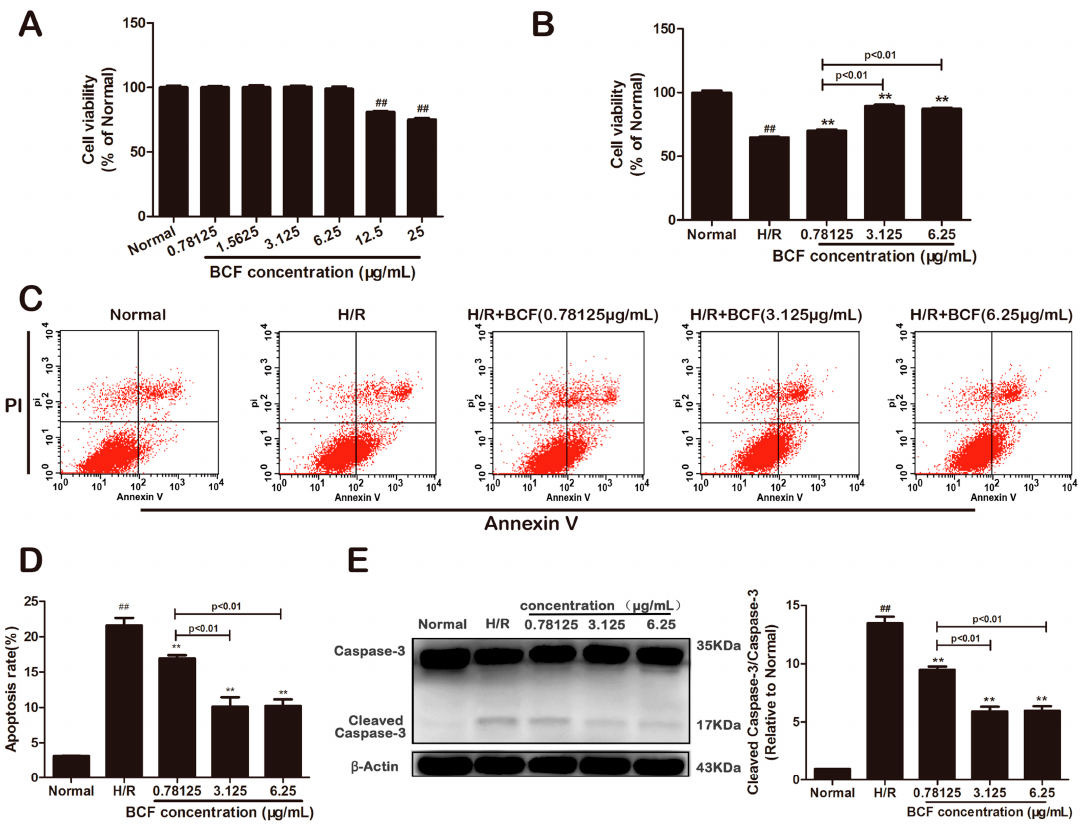
Figure 1. Effects of BCF on H/R induced myocardial apoptosis. H9c2 cells were pretreated with the indicated BCF concentrations for 4 h followed by 6 h of hypoxia and 12 h of reoxygenation or pretreated with indicated BCF concentrations for 24 h before the detection of relevant indexes. ( A ) Cytotoxicity was detected by CCK-8 assay; ( B ) Cell viability was determined by CCK-8 assay; ( C ) The apoptotic ratio of H9c2 cardiomyocytes was measured by flow cytometry using Annexin V-FITC and PI staining; ( D ) The apoptosis rate was quantified by BD FACS software; ( E ) Caspase-3 and cleaved caspase-3 was detected by western blotting. Values were represented as mean ± SD ( n = 6, each group). ## p < 0.01 vs. normal; ** p < 0.01 vs. H/R-treated cells.